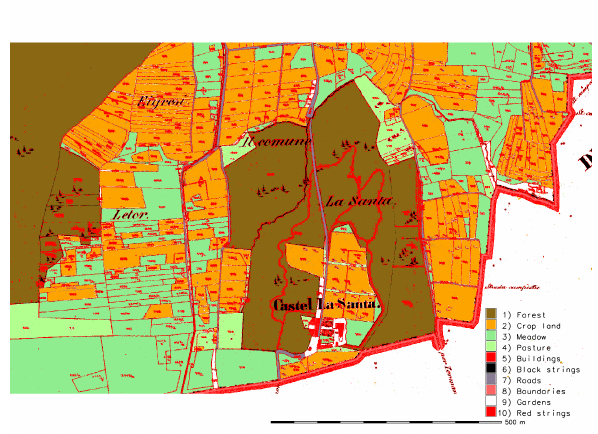
Figure 3. Classified map for supervised MLC - particular.